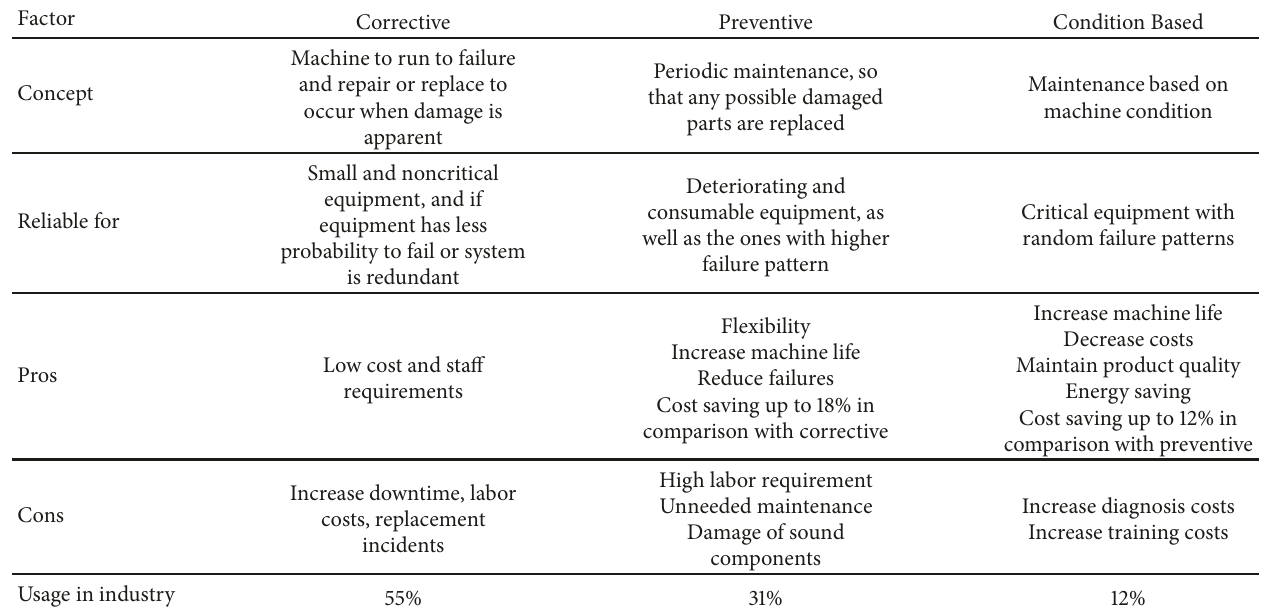
Table 1: Comparison between equipment maintenance strategies